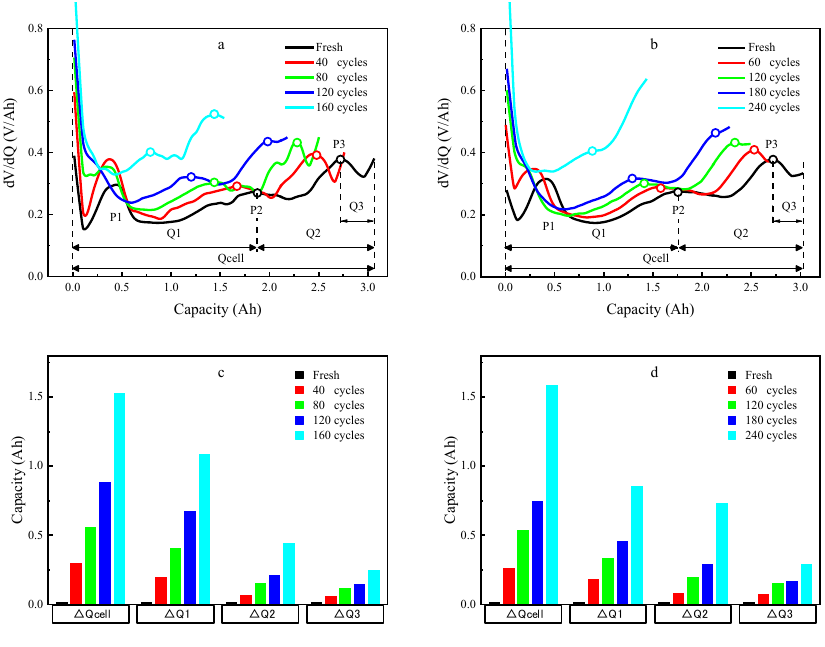
Fig. 4. The differential voltage curve at different cycles of battery #1 (a), and battery #3 (b). The capacity loss of each degradation mode at different cycles of battery #1 (c), and battery